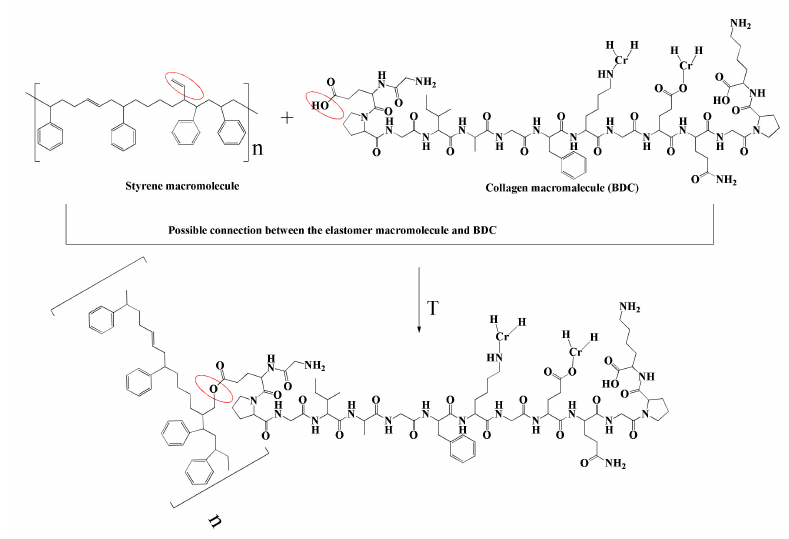
Figure 4. Possible mechanism of interaction between the elastomer macromolecule and BDC